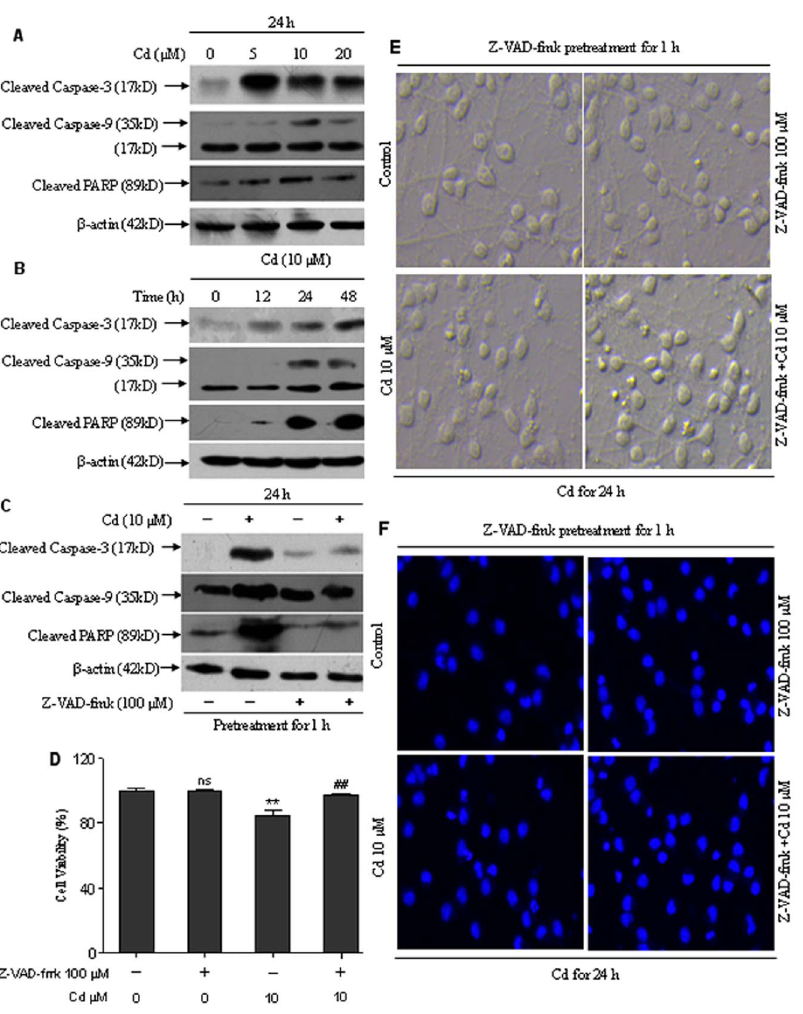
Figure 7. Cd induced neuronal apoptosis by caspase-dependent mechanism. (A and B) Cd increased cleavage of caspase-9, caspase-3 and PARP. Cells were exposed to 0–20 m M Cd for 24 h, or 10 m M Cd for 0–48 h and then analyzed by Western blotting. All experiments were performed twice. (C) A broad caspase inhibitor, Z-VAD-fmk, reverses Cd-induced cleavage of caspase-9, caspase-3 and PARP. Cerebral cortical neurons, treated with 10 m M Cd for 24 h following pretreatment with a pan caspase inhibitor, Z-VAD-fmk (100 m M) for 1 h, were harvested. Cell lysates were